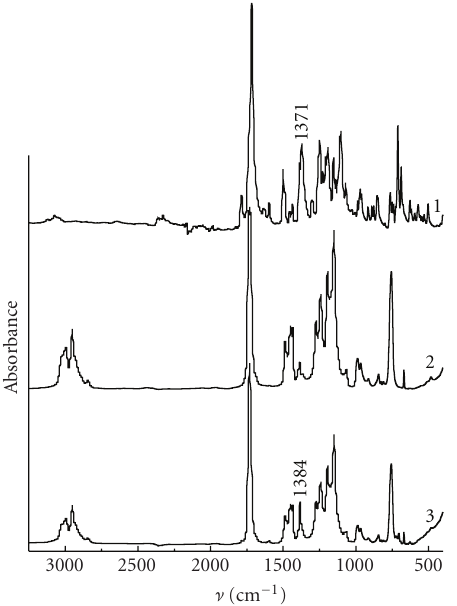
Figure 3: FTIR spectra of Diimide (1), PMMA (2), and PMMA obtained in the presence of 20wt.% of Diimide